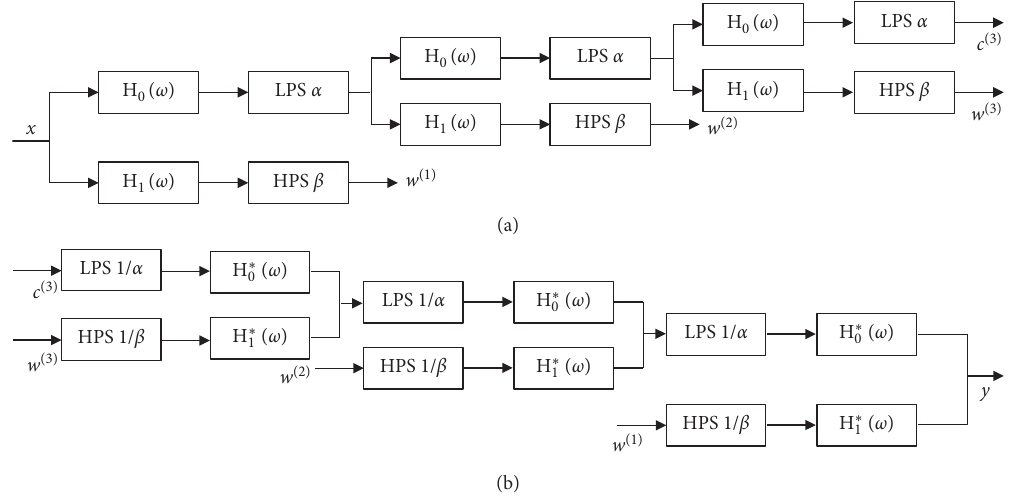
Figure 1: The corresponding dual channel filter banks of (a) decomposition process and (b) reconstruction